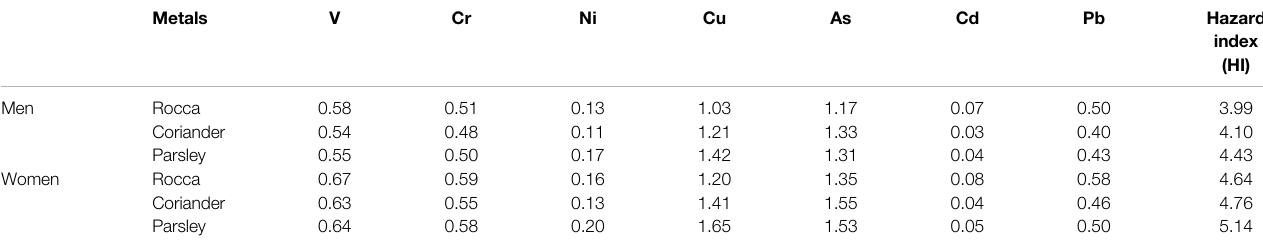
TABLE 3 | THQ and HI for men and women through the consumption of rocca, coriander, and parsley from the study areas.